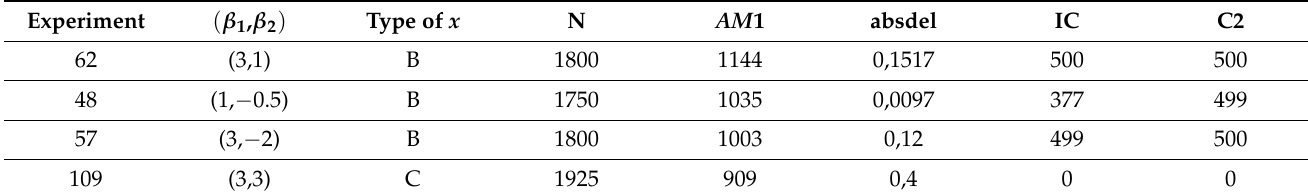
Table 6. Atypical experiments in Case 2. Behaviour of the selection